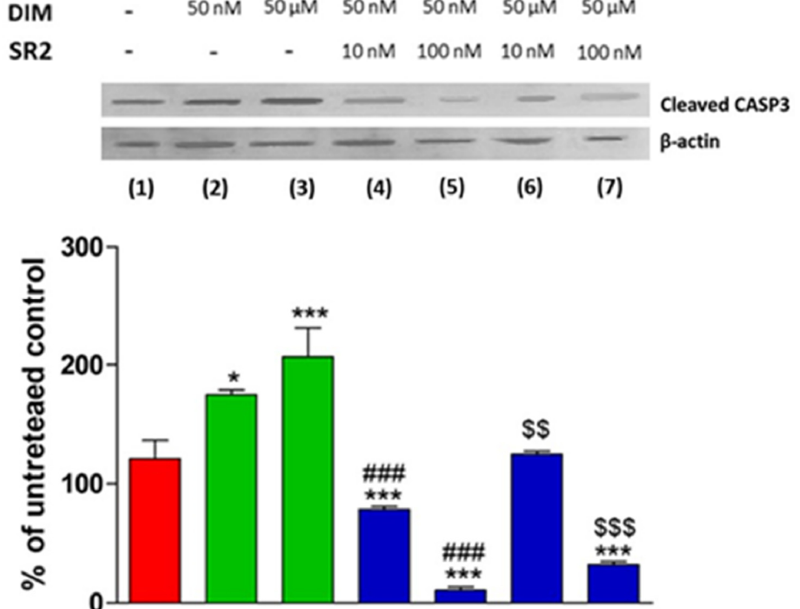
Figure 6. Western blot analysis of cleaved caspase 3 (CASP-3) levels in PC3 cells. The effects of different concentrations of DIM alone and in the presence of different concentrations of the CB 2 receptor antagonist SR2 are shown. Levels are normalized to actin internal loading control and expressed as a percentage compared to untreated control cells. Each data point is the mean percentage value ± S.E.M. ( n = 3). * p < 0.05 vs. CTRL (1), *** p < 0.001 vs. CTRL (1), $$ p < 0.05 vs. 50 $$$ p < 0.001 vs. 50 µ M (3), ### p < 0.001 vs. 50 nM DIM (2). (one-way ANOVA analysis of